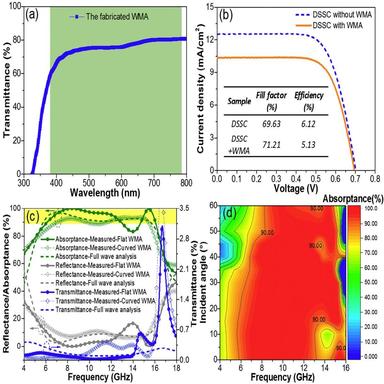
Measured properties of fabricated WMA. (a) The optical transparency. (b) Electrochemical properties (C\\V relations) of DSSC with (orange solid line) and without (blue dash line) the WMA on it. The inserted table is the filled factor and efficiency data. (c) The measured (dots) and simulated (dash lines) results of reflectance (gray), transmittance (blue) and absorptance (green) under TM plane waves. The solid-dot lines and the hollow-dot lines are measured results for flat WMA and curved WMA, respectively.